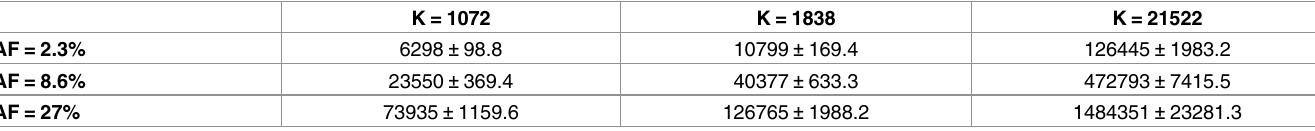
Table 2. Effect of handling time on estimated intake when concentrations in thermal paper are high. K = 1072